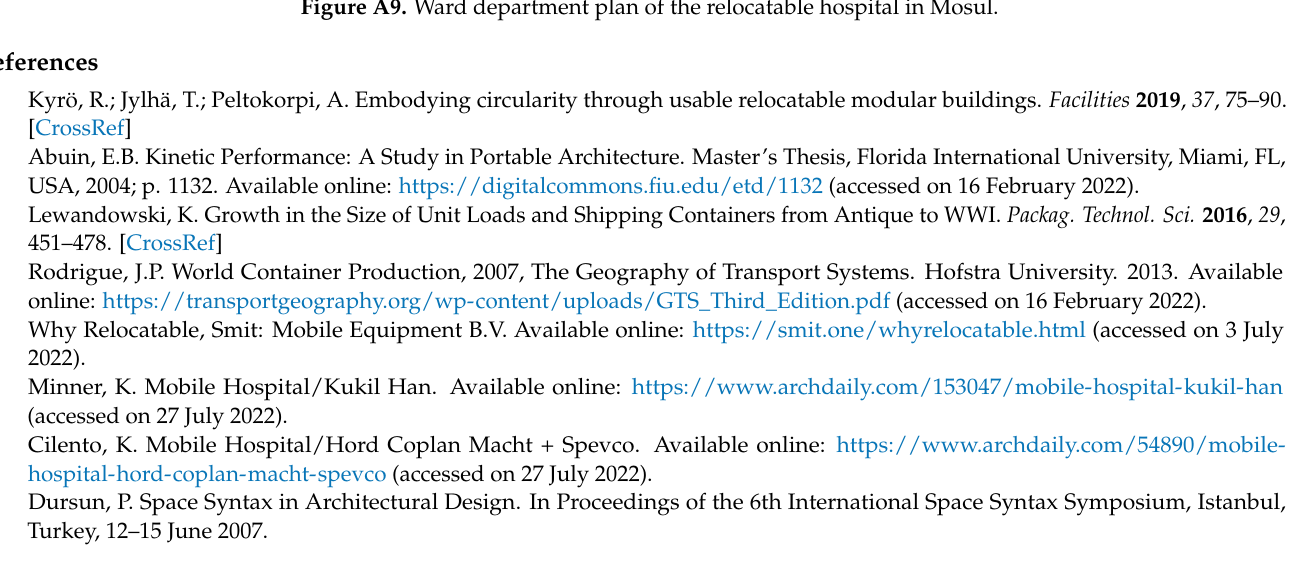
Figure A9. Ward department plan of the relocatable hospital in Mosul.